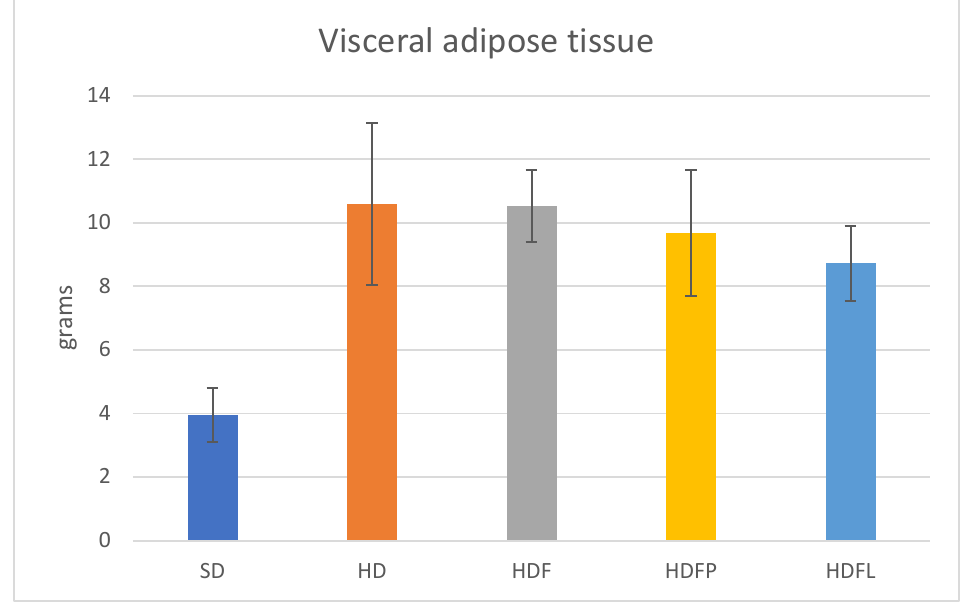
Figure 7. Visceral adipose tissue after eight weeks of treatment. Error bars are ± standard deviation. Treatment acronyms as in Figure 4.